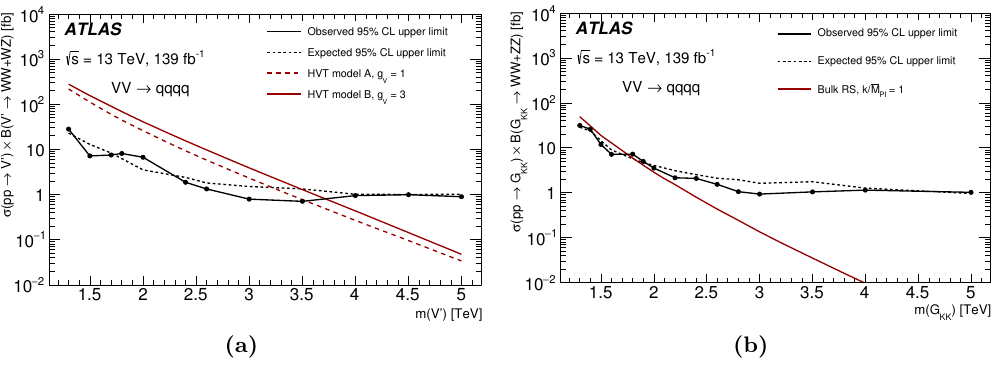
Figure 9 . Observed and expected limits at 95% CL on the cross-section times branching ratio for WW + WZ production as a function of (a) m , and for WW + ZZ production as a function of V 0 (b) the Bulk RS graviton m . The predicted cross-section times branching ratio is shown (a) as G KK dashed and solid lines for the HVT models A with g = 1 and B with g = 3, respectively, and V V (b) as a solid line for the bulk RS model with k=M = 1. Pl